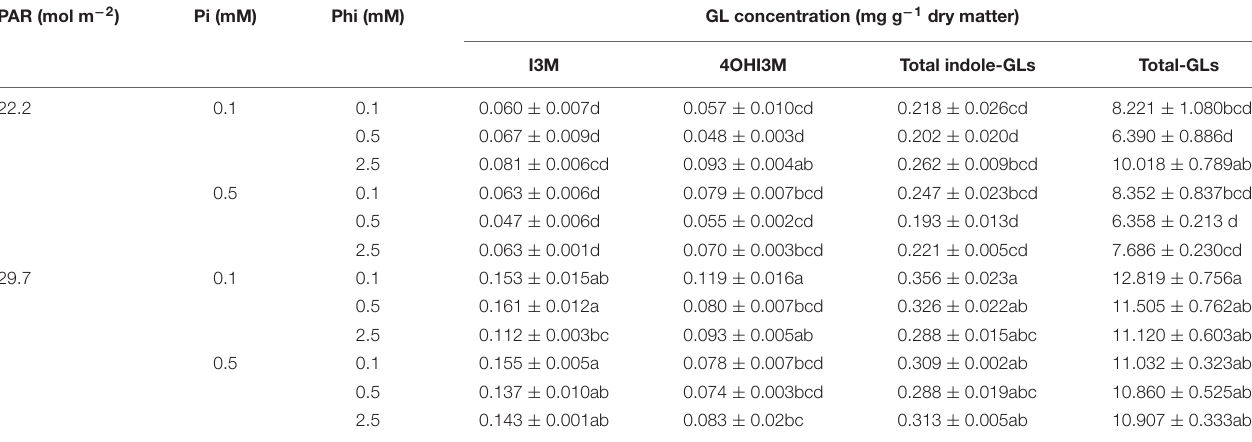
TABLE 4 | Mean daily photosynthetically active radiation (PAR), phosphate (Pi), and phosphite (Phi) affecting glucosinolate (GL) concentrations in B. juncea cv. Red Giant. PAR (mol m − 2 ) Pi (mM) Phi